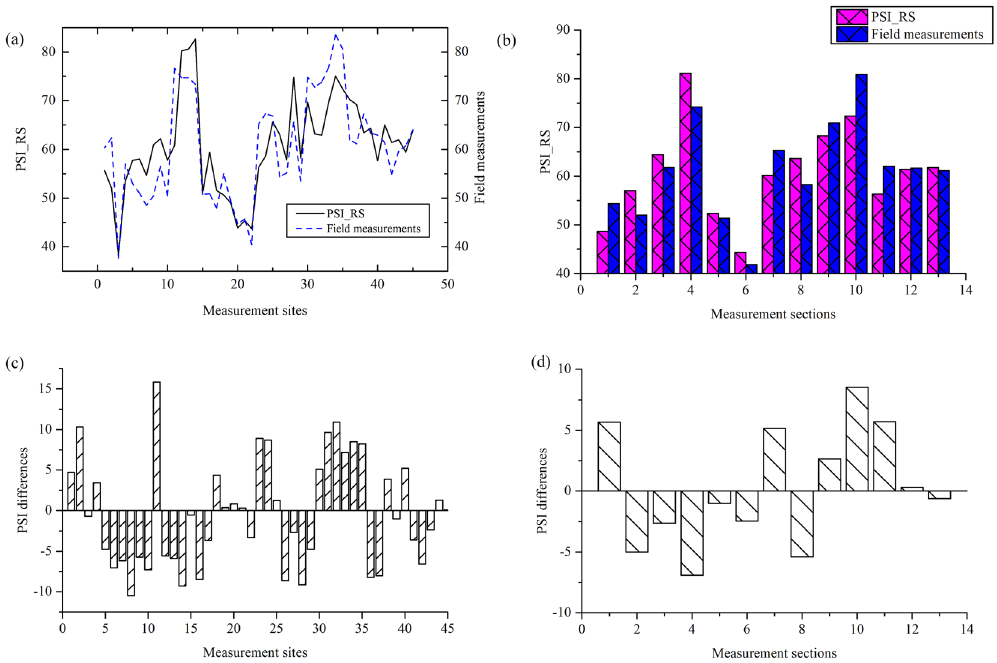
Figure 6. The evaluation results was validated by field measurements: ( a ) the comparison of 45 measurement sites; ( b ) the comparison of 13 measurement sections; ( c ) and ( d ) the differences of PSI values derived from corresponding to measurement sites and measurement sections.